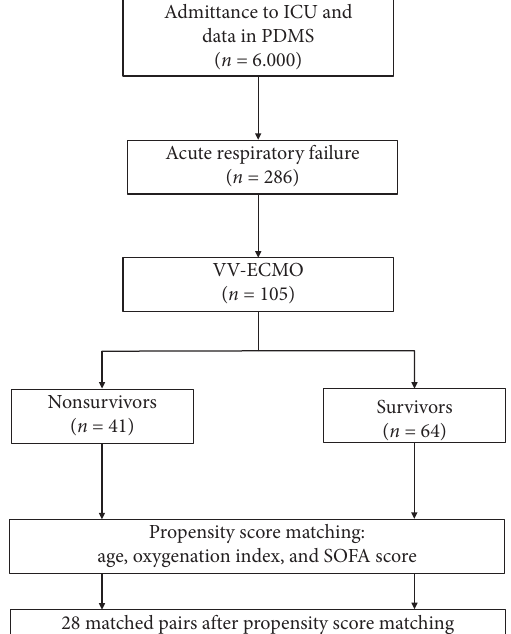
Figure 1: Patient selection and matching